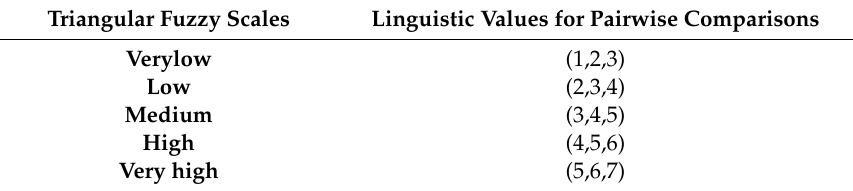
Table 3. Linguistic scales for pairwise comparisons and their fuzzy